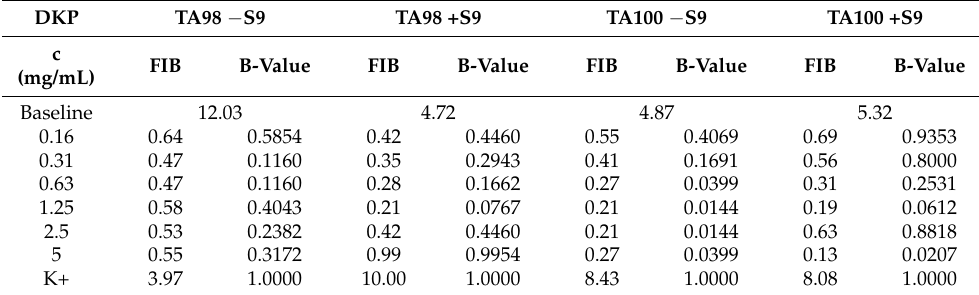
Table 5. The results of bacterial reverse mutation test for DKP. DKP TA98 − S9 TA98 +S9 TA100 − S9 TA100 +S9